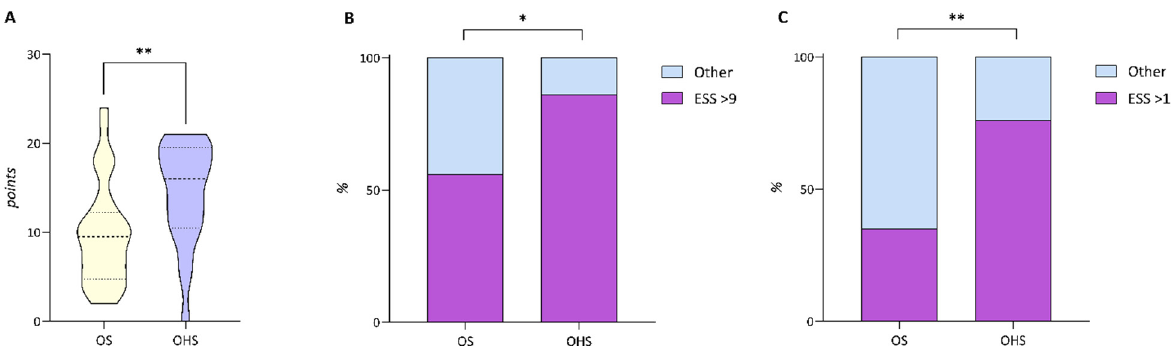
Figure 1. The violin plot ( A ) represents the global mean Epworth Sleepiness Scale (ESS) score, while bar charts ( B , C ) the differences between overlap syndrome (OS) and obesity hypoventilation syndrome (OHS) at several thresholds of ESS. * p < 0.05 ** p < 0.001.